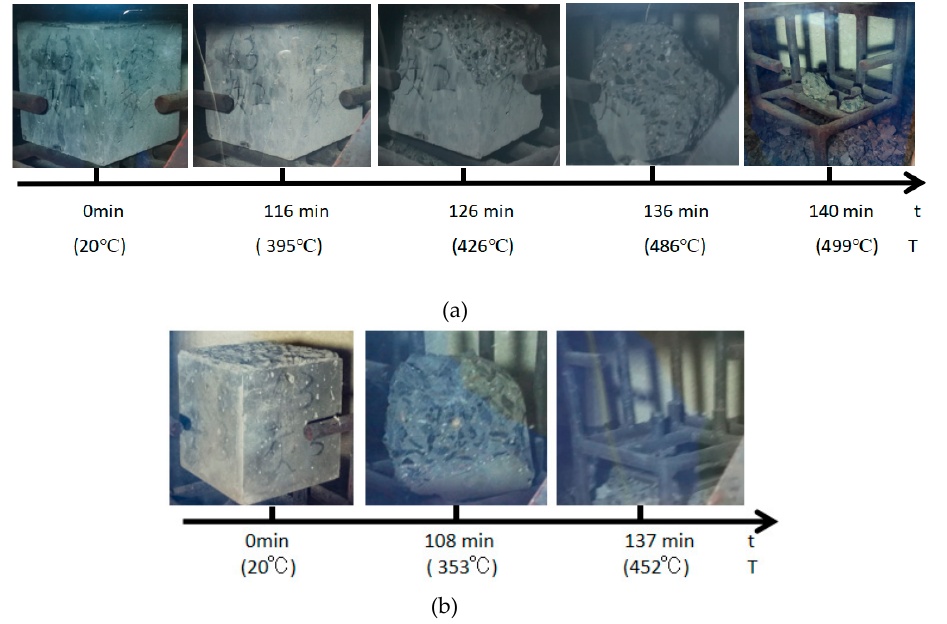
Figure 13. The explosion process of the carbon fiber specimens with different specimen sizes: ( a ) the 150-mm cube concrete specimen with carbon fiber and ( b ) the 100-mm cube concrete specimen with carbon.